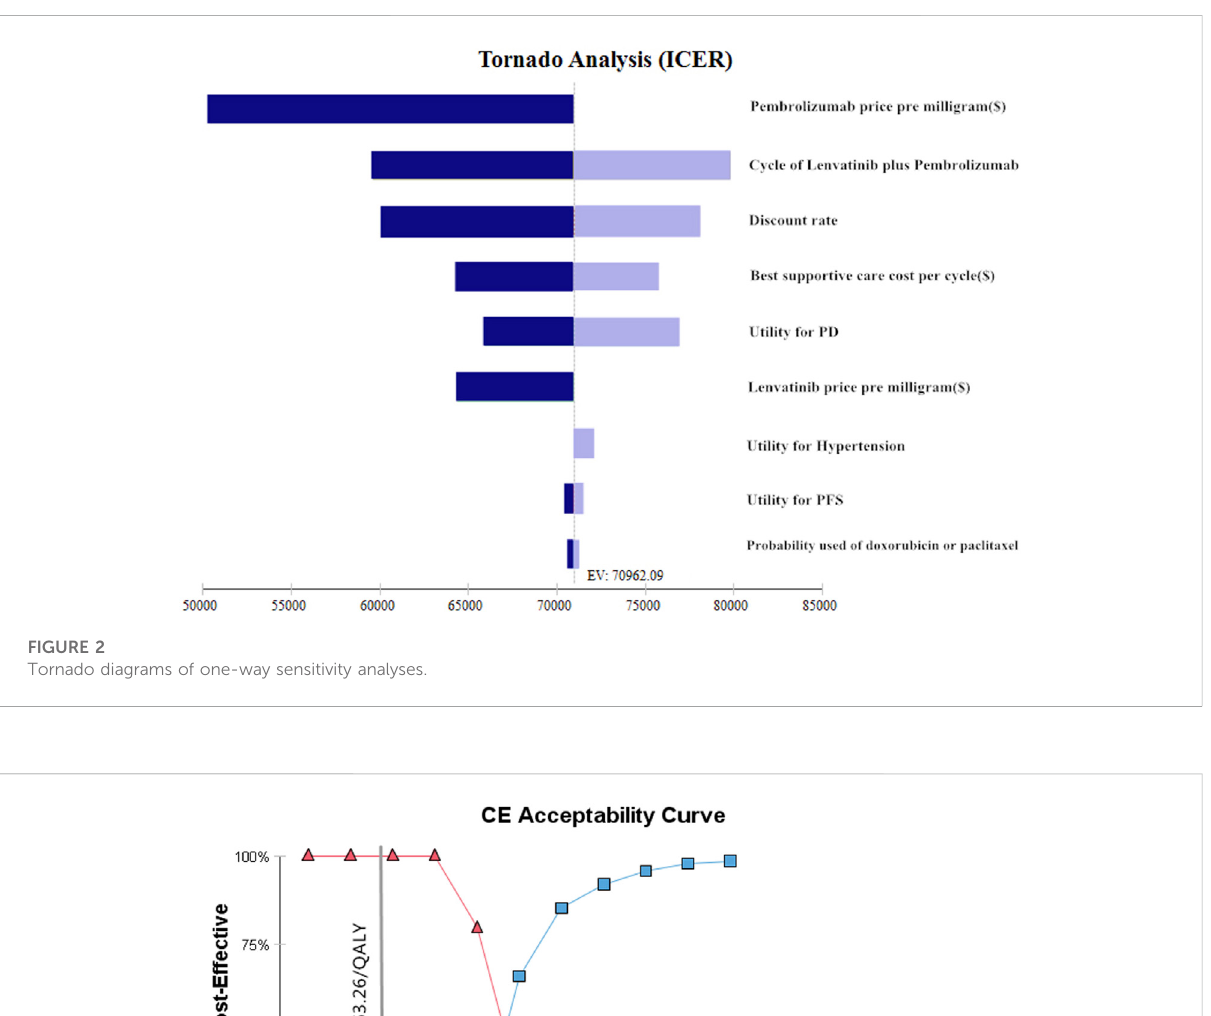
FIGURE 3 Cost-effectiveness acceptability curve. CE,